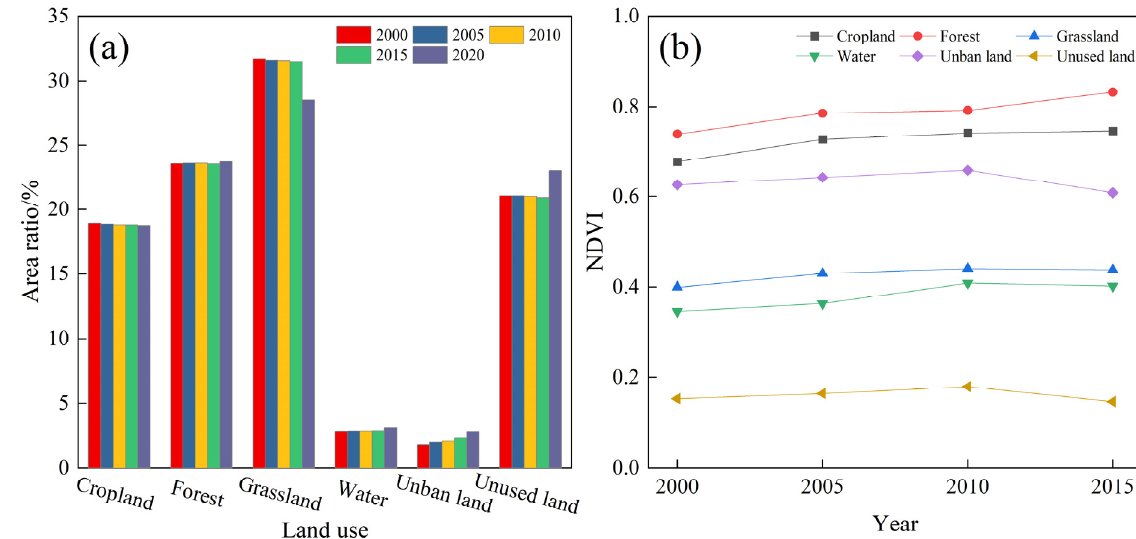
Figure 6. Effects of LUCC on NDVI: ( a ) five phases of LUCC change (in 2000, 2005, 2010, 2015, and 2020) and ( b ) trend of NDVI change corresponding to different LUCC types (in 2000, 2005, 2010, and 2015).